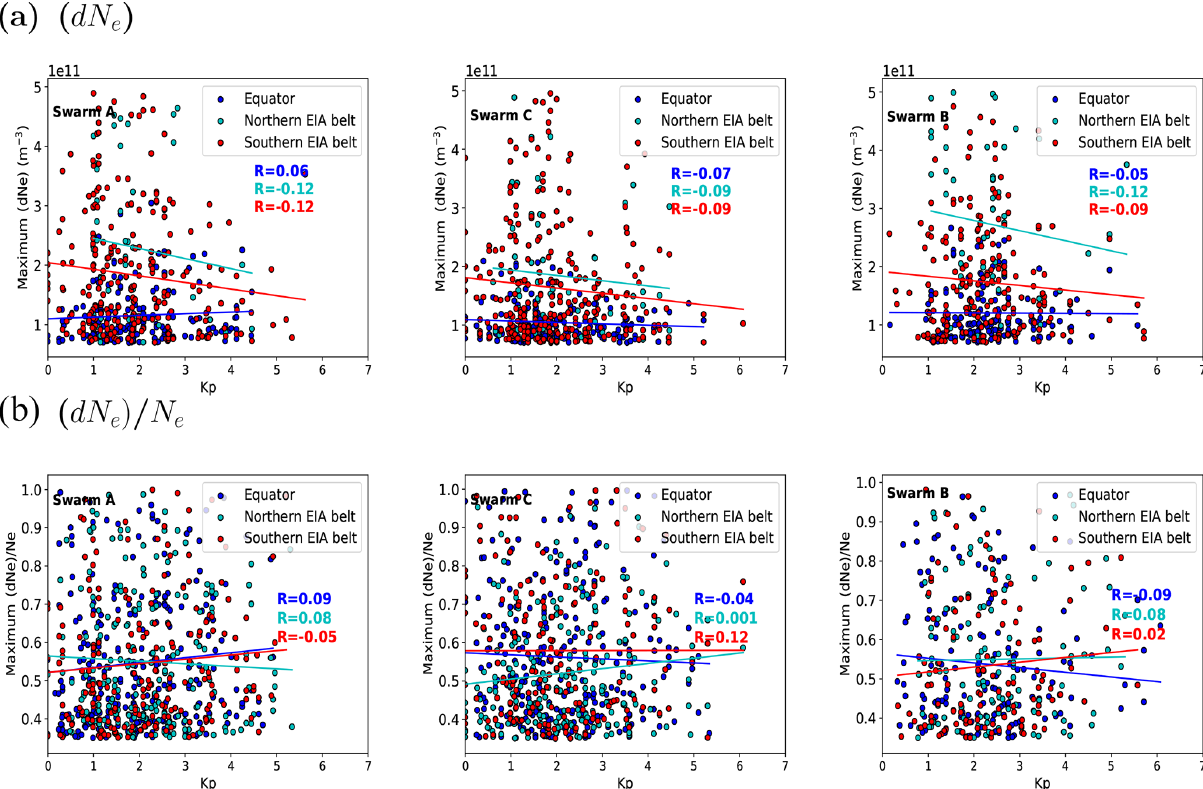
Figure 13. The distribution characteristics of (a) dN e and (b) dN e /N e with respect to the Kp index for the period from October 2014 to October 2018. The coloured solid lines in each panel represent a linear fit to the